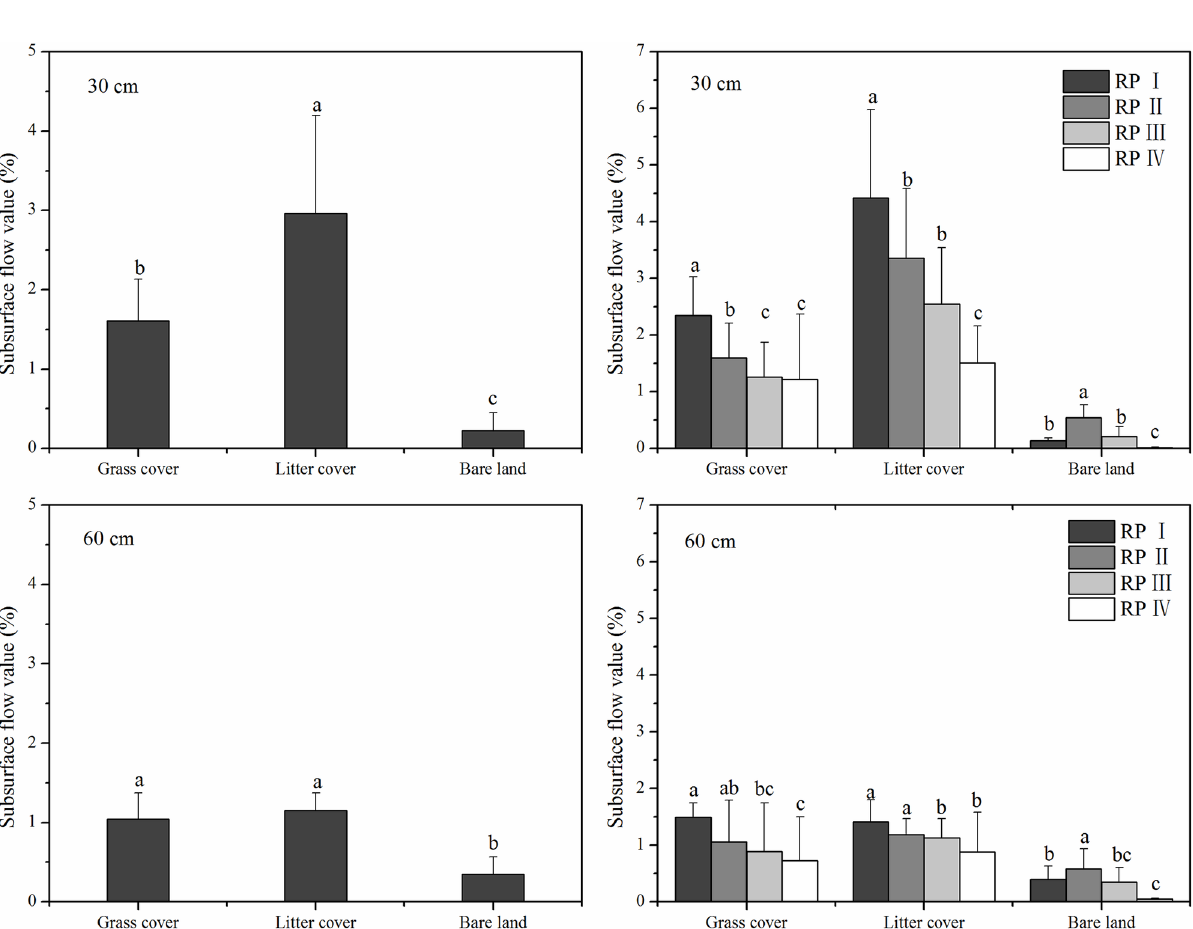
Fig 6. Subsurface flow values of three land cover types under different rainfall patterns.